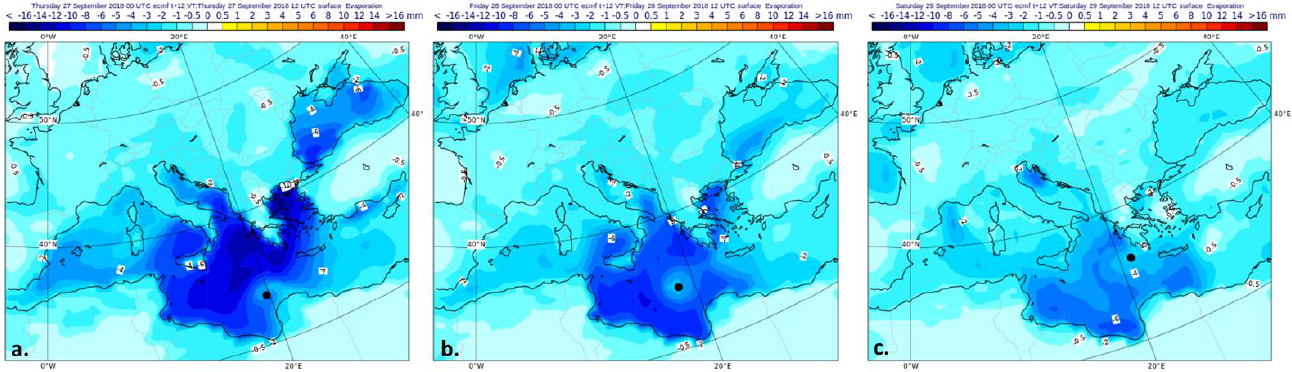
Figure 13. Cross-sections of wet-bulb potential temperature (isopleths), vertical velocity (ω) (coloured areas, in Pa/s, and horizontal wind (flags) following the cyclonic centre at ( a ) 27/12 UTC and ( b ) 28/12 UTC. Dashed blue lines represent the relative humidity value of 90%.